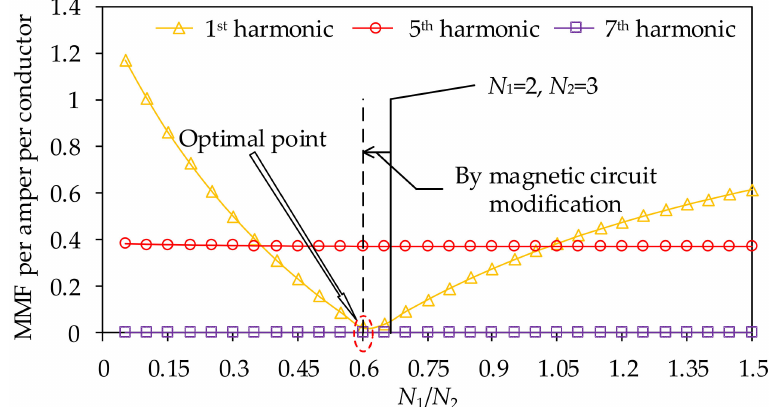
Figure 4. Variations of winding MMF harmonics of the proposed machine with N 1 / N 2